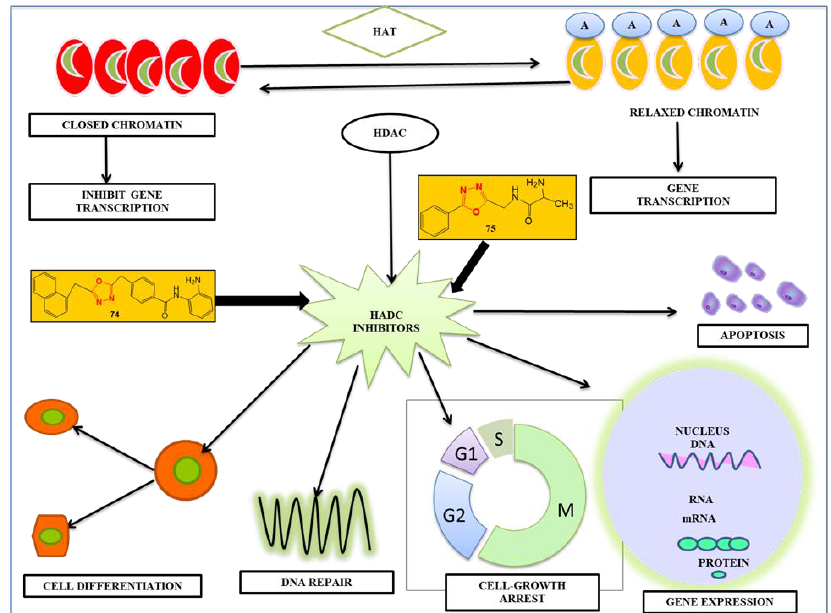
Figure 17. Histone deacetylase (HDAC) and its functions.